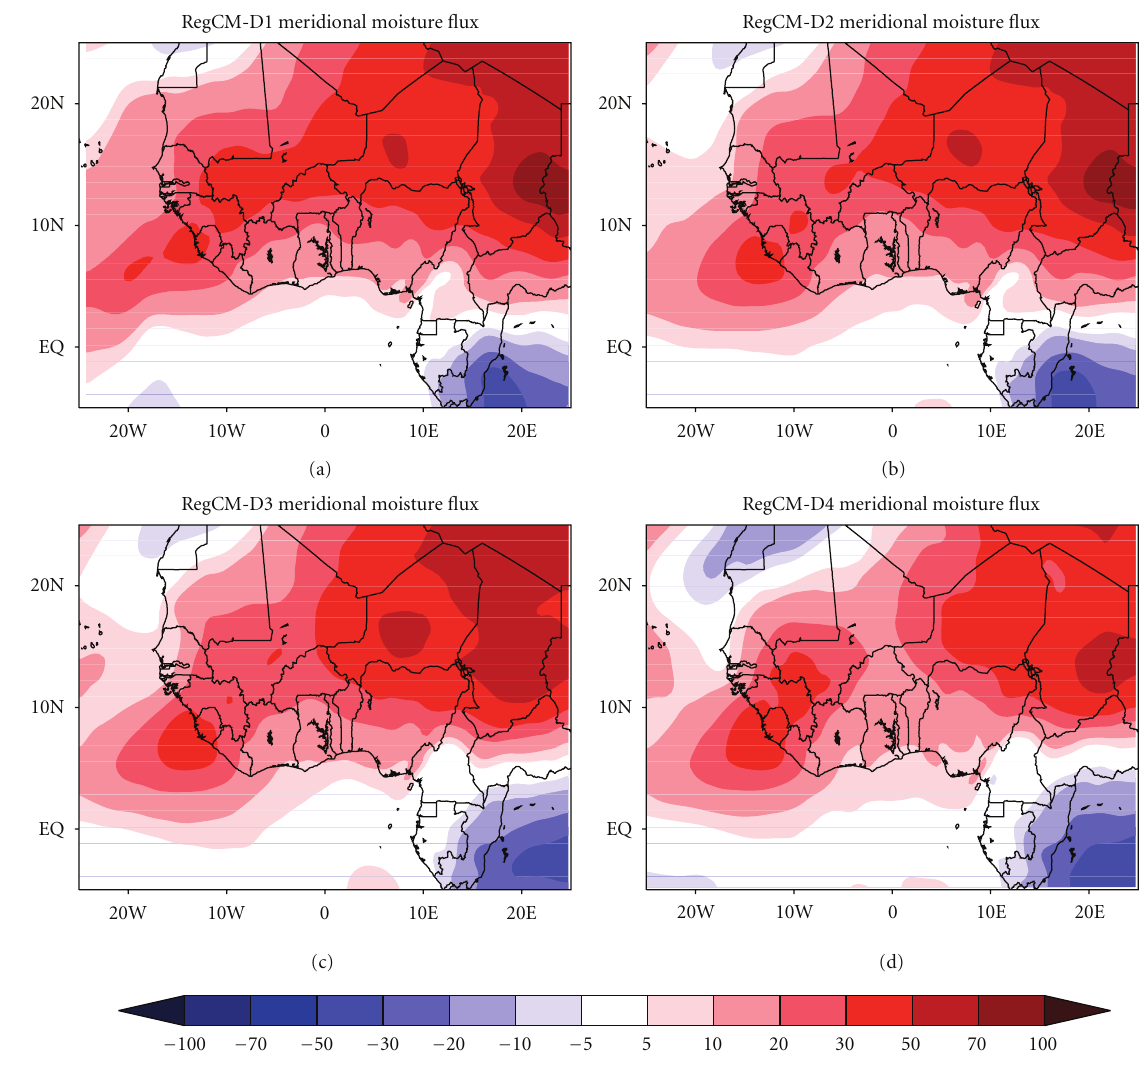
Figure 8: Mean JJA vertically integrated meridional moisture flux averaged for the period 2001–2005 for (a) RegCM-D1, (b) RegCM-D2, (c) RegCM-D3, and (d) RegCM-D4. Positive values denote southerly flow. Units are expressed in kg m − 1 s − 1